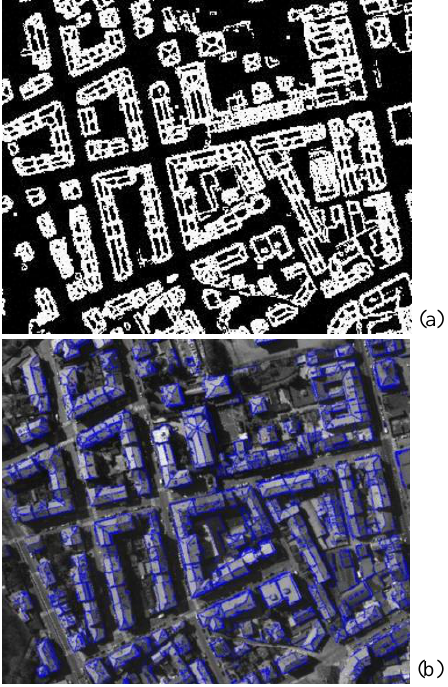
Figure 13. Roof outlines in the range data (a) and corresponding extracted edges on the images (b).